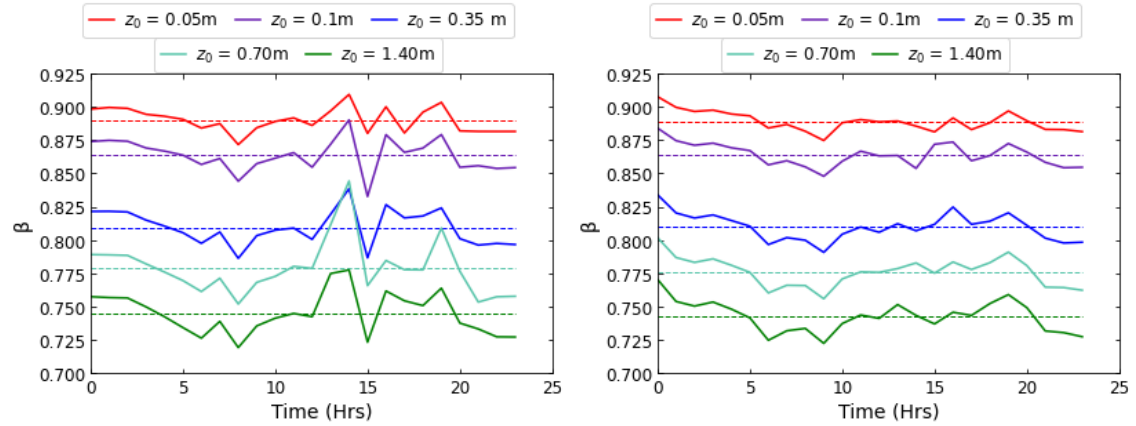
Figure 3. Effects of wind-farm roughness length ( z 0 ) on the farm wind-speed reduction factor ( β ) computed using two different data-sampling methods: ( left ) one-day instantaneous ( right ) two-day hourly average. Dashed lines show the daily average value for each case.